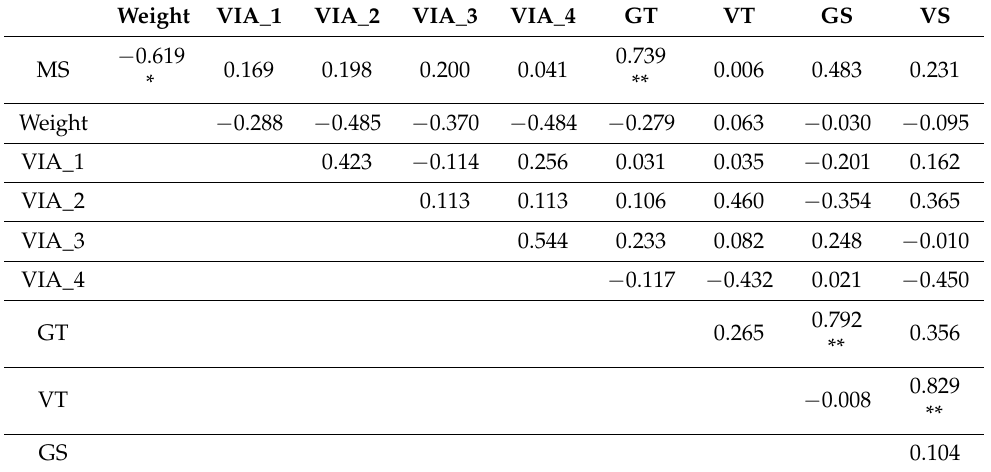
Table 3. Pearson’s correlation calculated to determine lineal relationships between all measures. Vertical impact acceleration (VIA), mean speed (MS) (m/s), gastrocnemius stiffness (GS) (N/m 2 ), gastrocnemius tone (GT) (Hz), vastus lateralis stiffness (VS) (N/m 2 ), vastus lateralis tone (VT) (Hz) * p < 0.05; ** p <